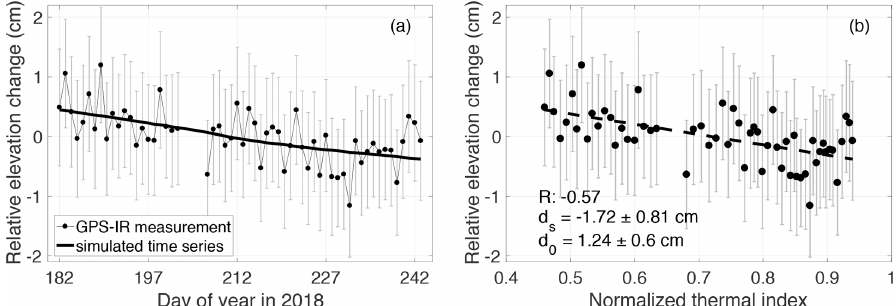
Figure 6. (a) Time series of GPS-IR measurements of ground surface elevation changes and the simulated ones based on the model parameters d s and d 0 in (b) during DOY 182–243 in 2018. (b) Scatter plot between the ground surface elevation changes and the normalized thermal indices and their best linear fit (dashed line). d s and d 0 are the slope and intercept of this fit line.